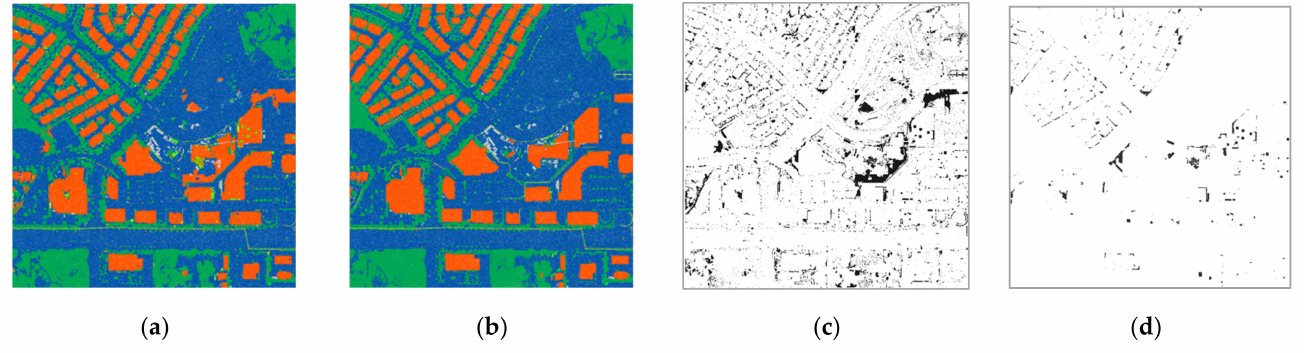
Figure 18. Results of semantic segmentation of test data 1 for Case 3: ( a ) prediction; ( b ) ground truth (i.e., label data); ( c ) difference between prediction and ground truth for all classes; ( d ) difference between prediction and ground truth for building class